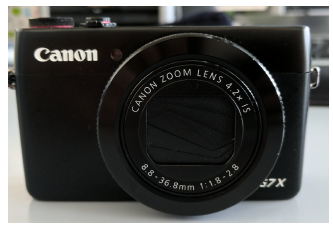
Figure 2. Canon G7X